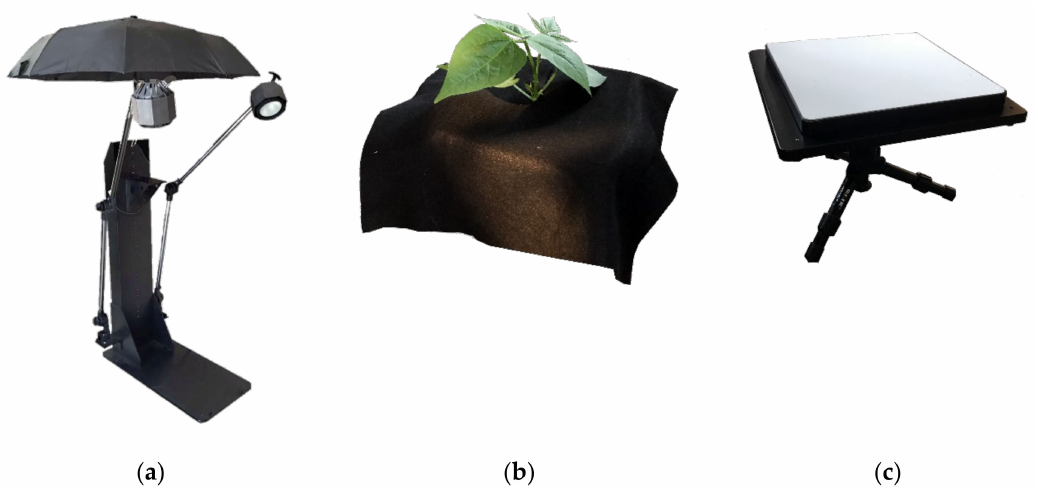
Figure 3. ( a ) The assembly used for collecting spectral data with the spectroradiometer, ( b ) black felt covering the soil background to capture pure vegetative spectra, and ( c ) the Spectralon panel used for calibration to reflectance and normalizing samples to correct for illumination di ff erences between plants and collection